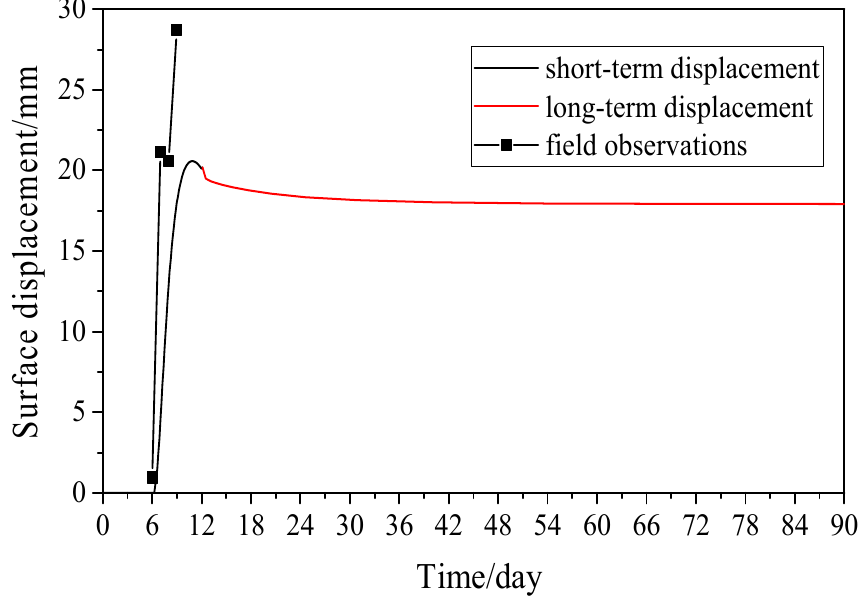
Figure 7. Simulated and monitored segment displacement time-history curves. Figure 7. Schematic diagram of shield tunnel excavation. The horizontal settlement trough of the ground surface after the shield machine passed completely during the construction period was compared with the field observation. As shown in Figure 8, the simulated surface settlement trough presented a standard bell- shaped curve, with a maximum settlement of − 10.98 mm directly above the tunnel axis. The simulated results were consistent with the value and distribution of the monitored surface settlement trough. However, the monitored surface settlement trough had a certain asymmetry, which was different from the simulation results. The possible reason is that the shield machine has a large horizontal axis deviation during the tunneling process, and the numerical model established in this paper does not consider the deviation of the shield machine from the tunnel